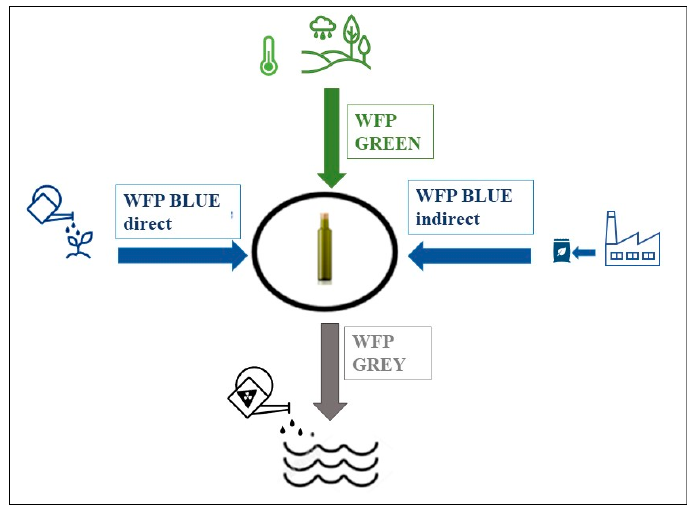
Figure 2. Schematization of the water footprint components: green, blue and grey. Particularly, the green WF (WF green , m 3 kg − 1 and m 3 L − 1 ) was calculated as follows: WF product, green = CWU green /Y where: